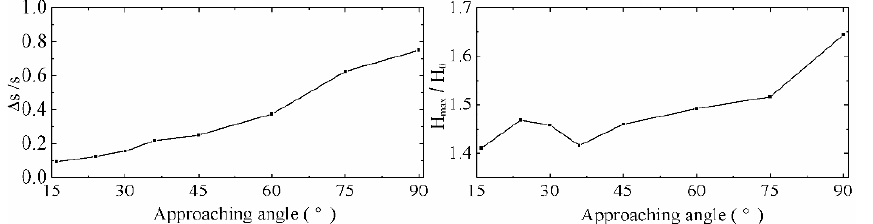
Figure 10. The non-dimensional relative position and the maximum wave height.